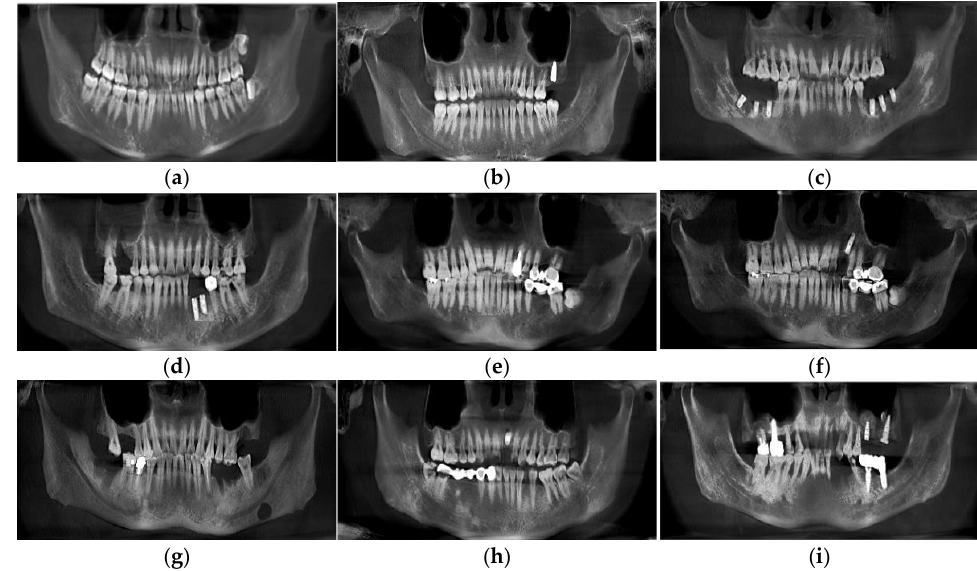
Figure 7. Different panoramic image effects. ( a ) Panoramic image of normal oral. ( b,c ) Panoramic image of implant in molar area. ( d ) Panoramic image of the implant in the canine area. ( e – g ) Panoramic image of crown restoration in molar area. ( f – i ) Panoramic image of crown restoration in canine